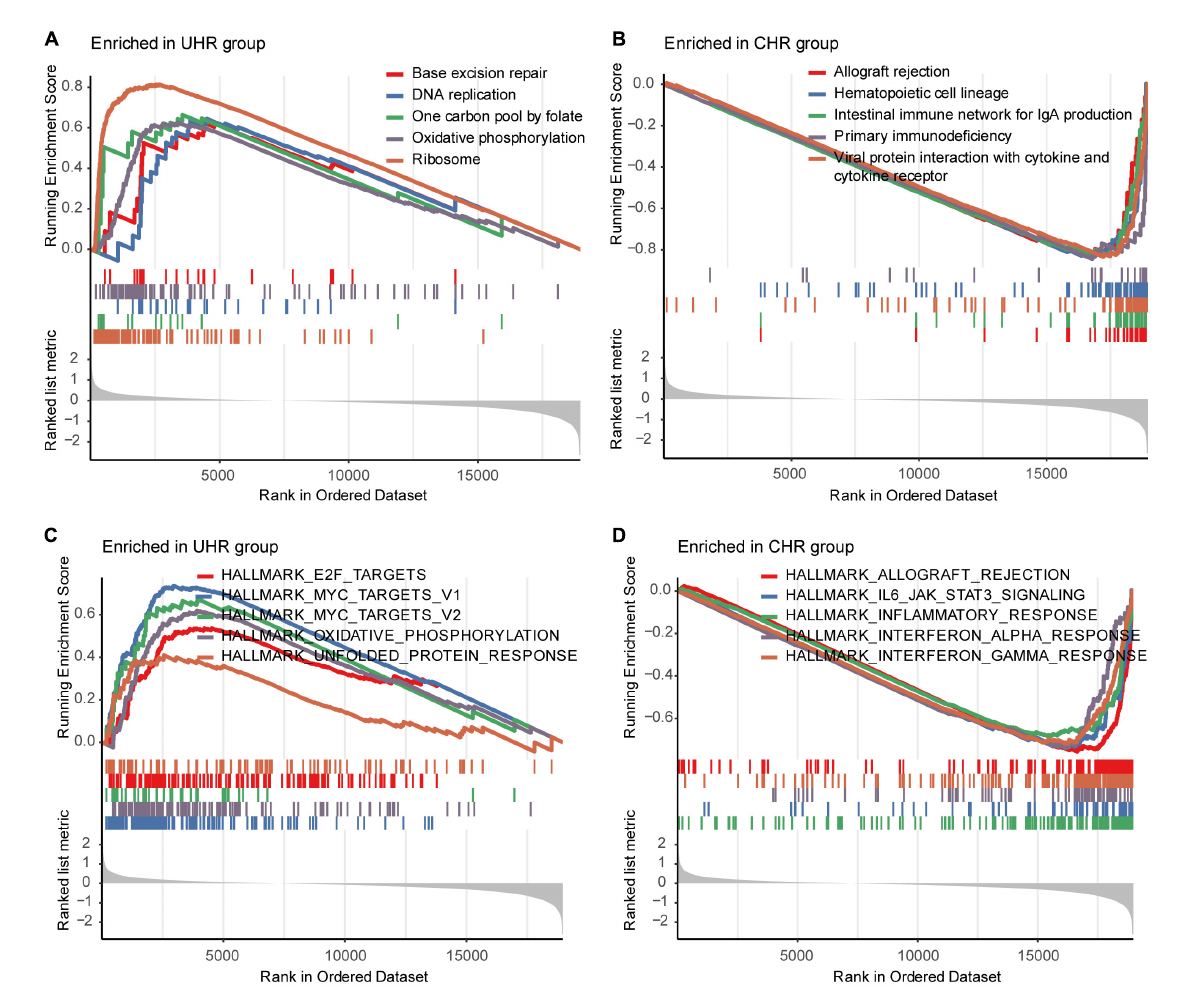
FIGURE5 Representative pathways enriched in UHR and CHR groups from the SEQC cohort. The top five significantly enriched KEGG pathways in the UHR (A) and CHR (B) HRNB patients. The top five significantly enriched hallmarks in the UHR (C) and CHR (D) HRNB